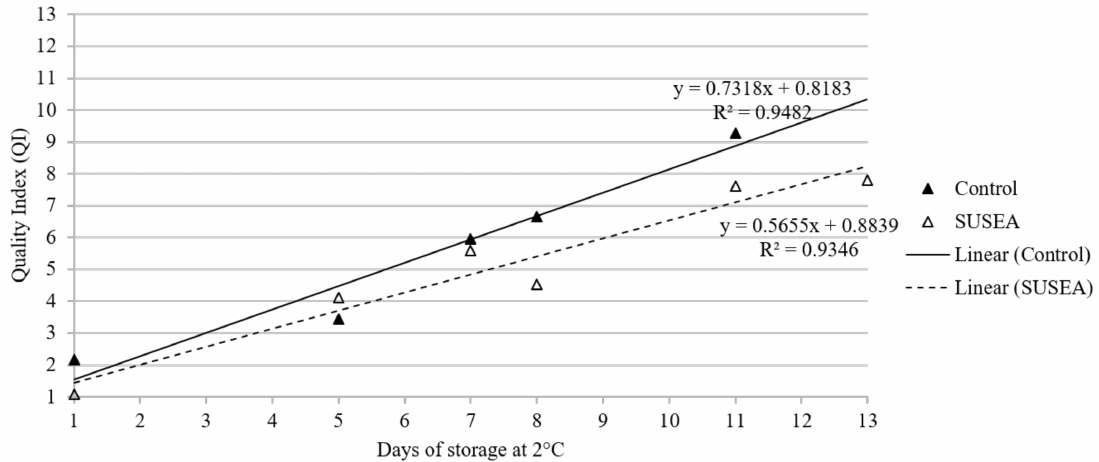
Figure 1. Quality index of gilthead seabream fillets stored isothermally at 2 ◦ C for the Control (untreated) and SUSEA (Treated) fillets. Continuous lines represent the statistical fit of a linear model. The R 2 and equation of the linear model fit are included in the plot (Top: Control; Bottom: SUSEA).